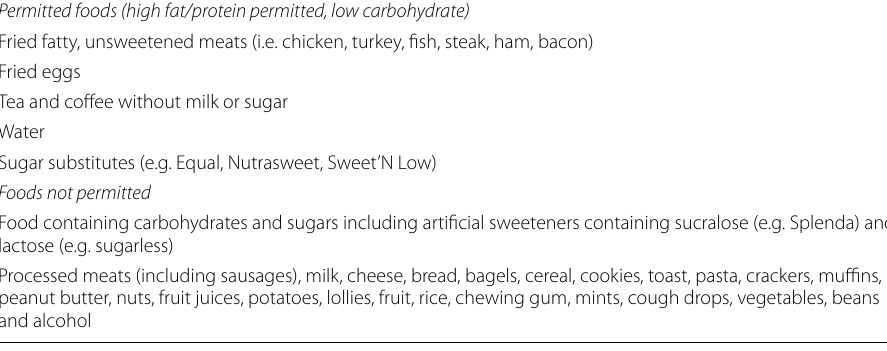
Permitted foods (high fat/protein permitted, low carbohydrate) Fried fatty, unsweetened meats (i.e. chicken, turkey, fish, steak, ham, bacon) Fried